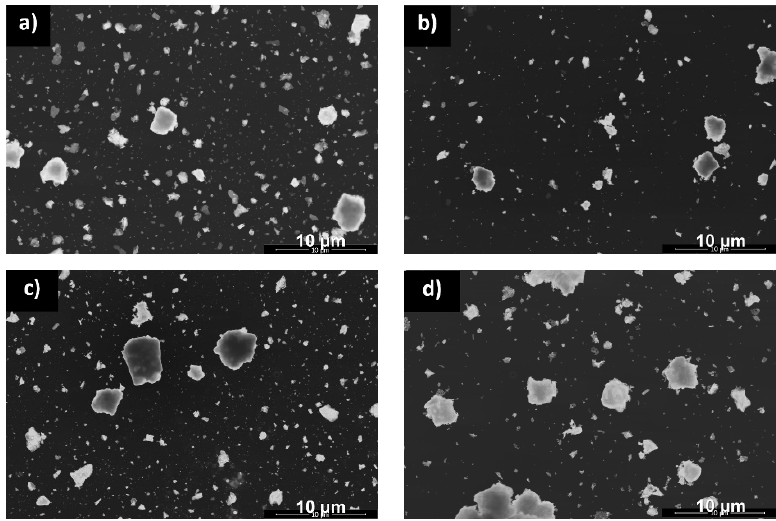
Figure 3. SEM micrographs of the powders calcined at different temperatures 170 °C ( a ), 470 °C ( b ), 760 °C ( c ) and 960 °C ( d ).